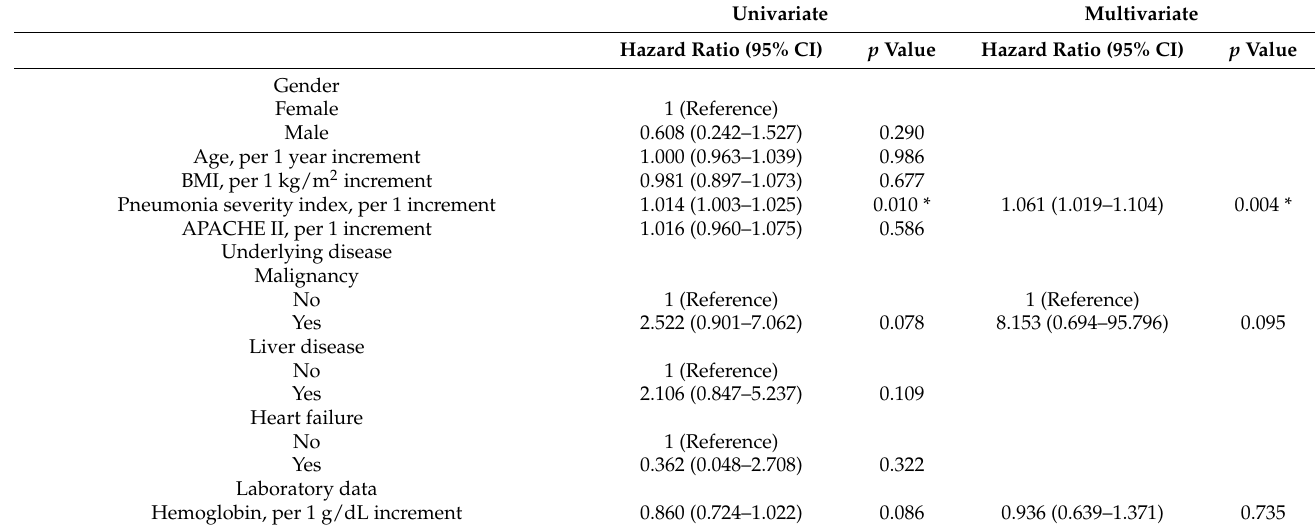
Table 6. Predictive factors for 60 days mortality in AKI requiring RRT